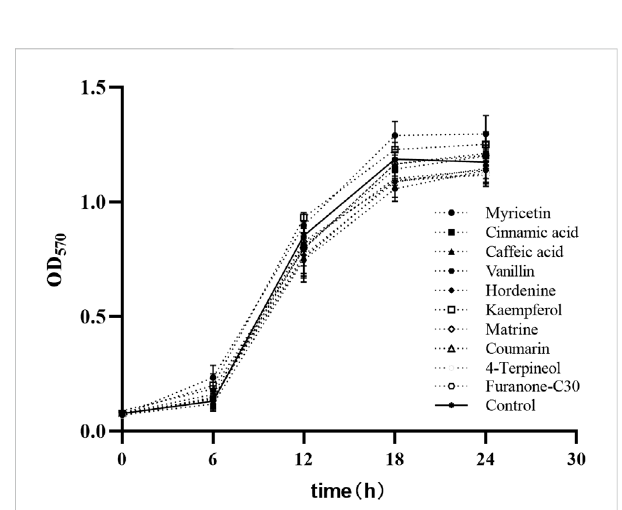
FIGURE 2 Bacterialgrowthcurvesof12XDRABinthepresenceof9TCMMs at sub-MIC. Control, no TCMM; Myricetin (1/8 MIC = 32 μ g/mL), cinnamic acid (1/8 MIC = 256 μ g/mL), caffeic acid (1/8 MIC = 256 μ g/ mL), vanillin (1/8 MIC = 256 μ g/mL), hordenine (1/8 MIC = 128 μ g/mL), kaempferol (1/8 MIC = 64 μ g/mL), matrine (1/8 MIC = 256 μ g/mL), coumarin (1/8 MIC = 32 μ g/mL), 4-terpineol (1/8 MIC = 64 μ g/mL) andfuranoneC30(1/8 MIC= 4 μ